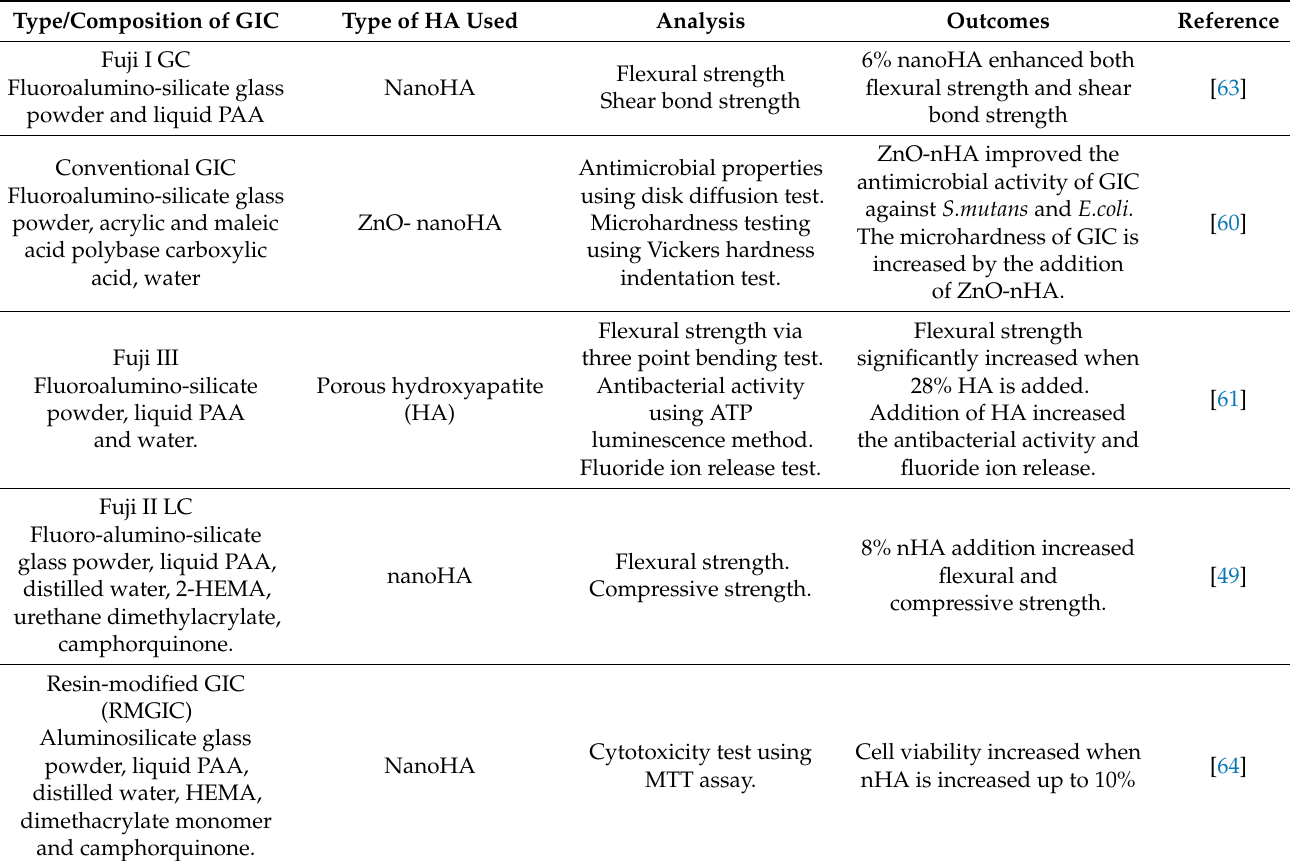
Table 1. Effects of Hydroxyapatite Incorporation into